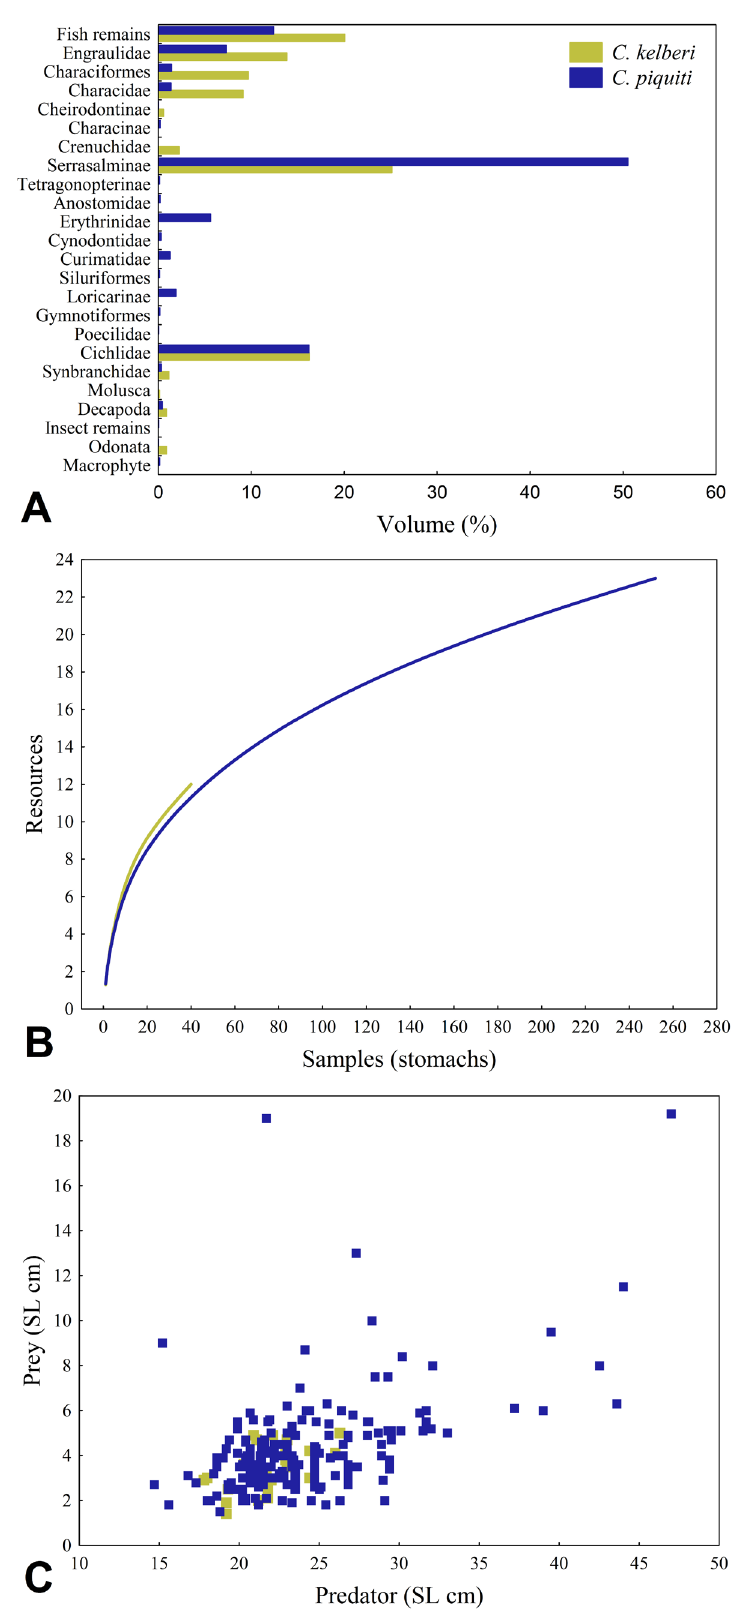
FIGURE 3 | Comparative feeding ecology of Cichla kelberi and C. piquiti . A. Food resources (percentage) consumed by each species, grouped in broad categories. B. Resource accumulation curves based on sampling effort (stomachs analyzed). C. Relationship between the standard length (cm) of C. kelberi and C. piquiti (predators) and the standard length (cm) of consumed prey (only